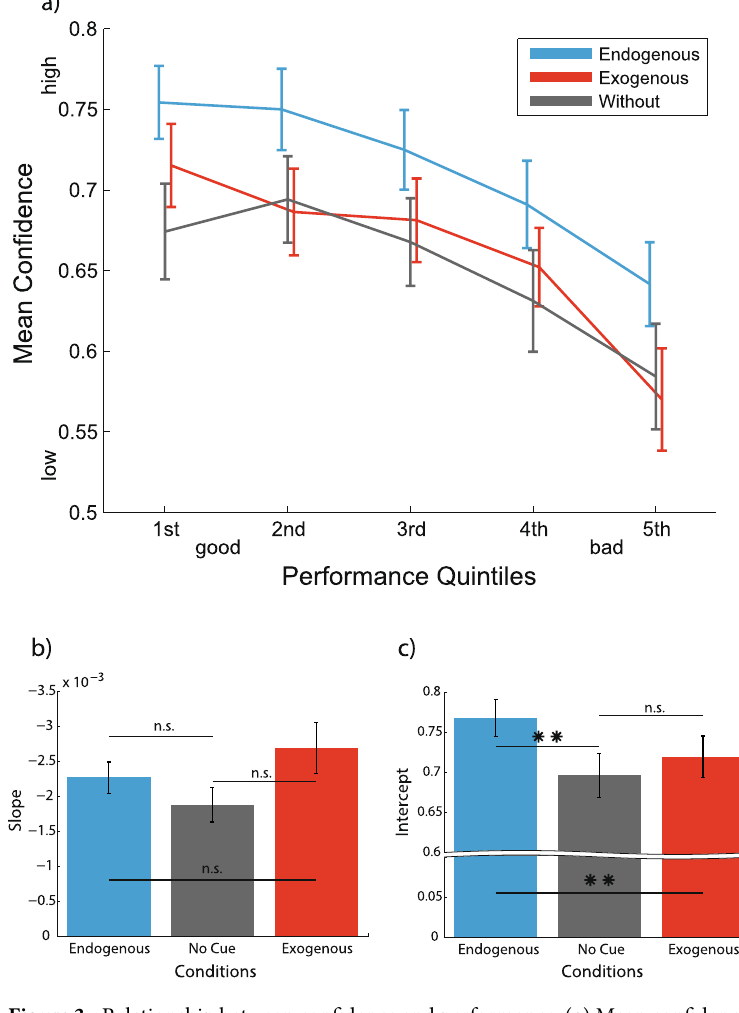
Figure 3. Relationship between confidence and performance. ( a ) Mean confidence is higher in the endogenous attention condition for a wide range of performances. For this plot we binned single subject data into quintiles based on performance. Shown is the grand average for confidence in the respective performance quintile. Error bars are standard error of the mean. ( b–c ) A linear model was fit to the data for every participant for every attentional condition. Shown are the mean values for the slope ( b ) and the intercept ( c ) of the linear fit for every condition respectively. Asterisks denote significant results of the post-hoc comparison; ** p < 0.01, * p < 0.05, n.s.: not significant (p > 0.05). Error bars are standard error of the